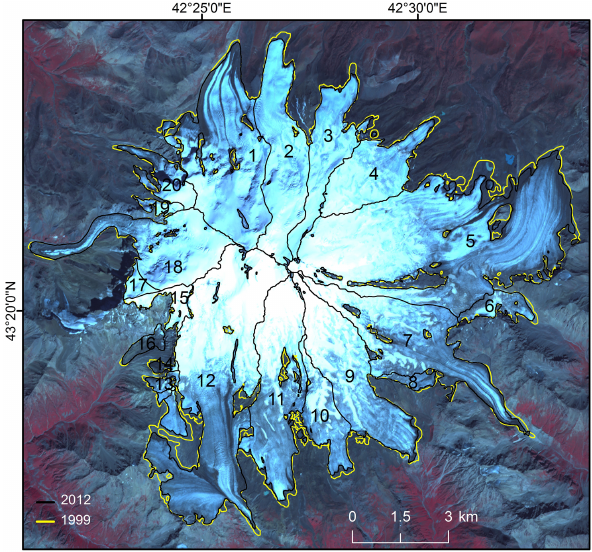
Figure 4. Changes in glacierized area of Mt. Elbrus between 1999 and 2012. See Table 4 for the statistics of changes in areas of indi- vidual glaciers. The 1999 Landsat ETM + image (Table 1) is used as